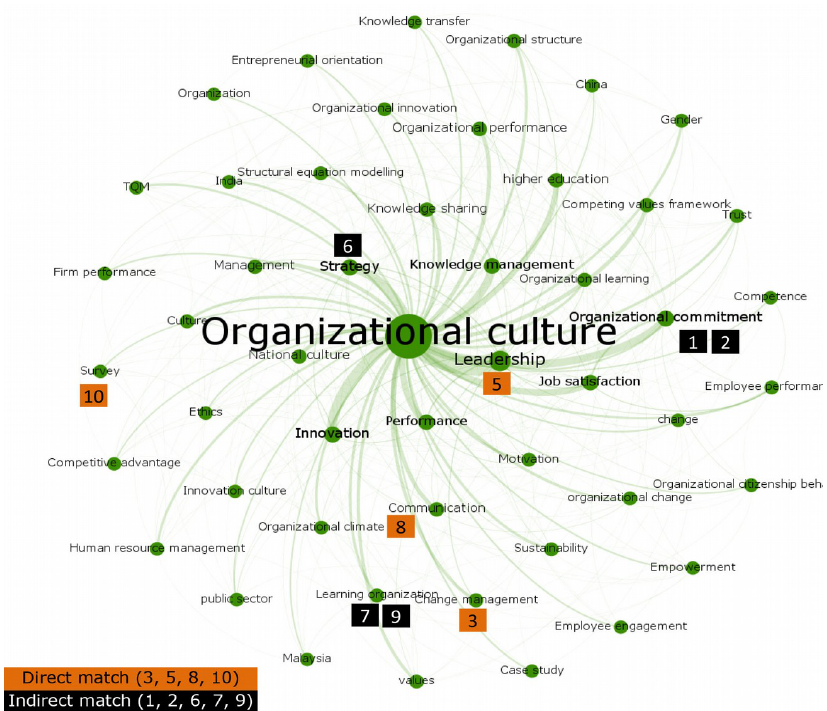
Figure 9. Networks of top 50 authors’ keyword co-occurrence on Organizational